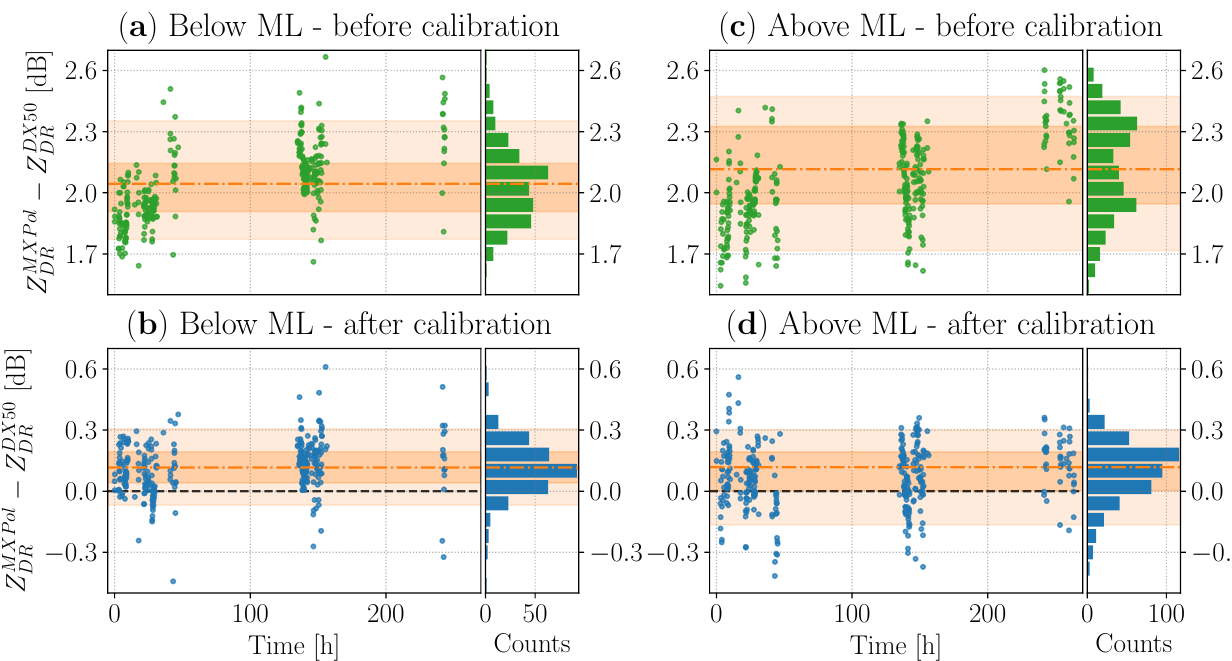
Figure 7. Time evolution of the agreement between the two radars for the PAYERNE campaign. ( a ) Time series of the differences between the median differential reflectivity of MXPol ( Z MXPol ) and the one of DX50 ( Z DX 50 ), before calibration DR DR and using only radar volumes below the melting layer. On the right, the distribution of all differences. The orange dashed and dotted line displays the median value of this distribution. It is surrounded by two orange patches of increasing transparency, covering respectively the region between the quantiles q = 0.25 and q = 0.75 and the one between q = 0.05 and q = 0.95. ( b ) Analogous to the first panel, using calibrated Z DR measurements. A black dashed line has been added to highlight the position of the 0 dB difference. ( c ) and ( d ) as the first two panels, but above the melting